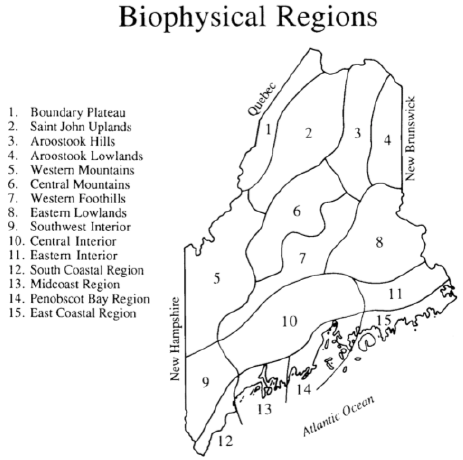
Figure 1. Maine Biophysical Regions, delineated on the basis of plant distributional data and climatic features [12].